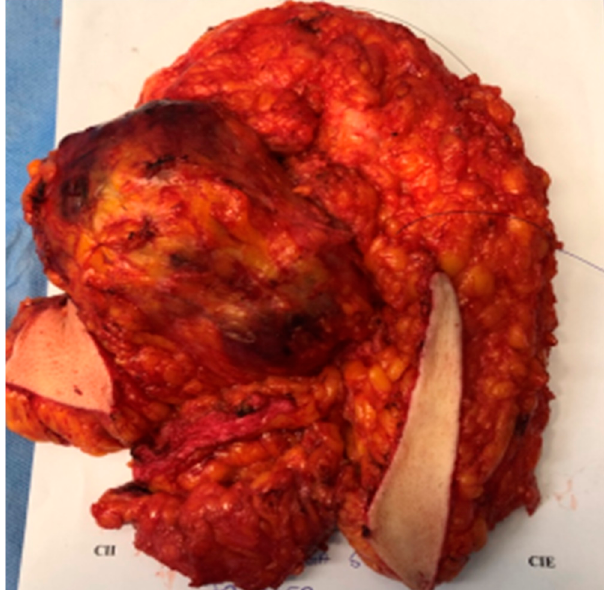
Figure 4. Macroscopic appearance of the breast PT. Excision specimen—skin-reducing mastectomy in the left breast.